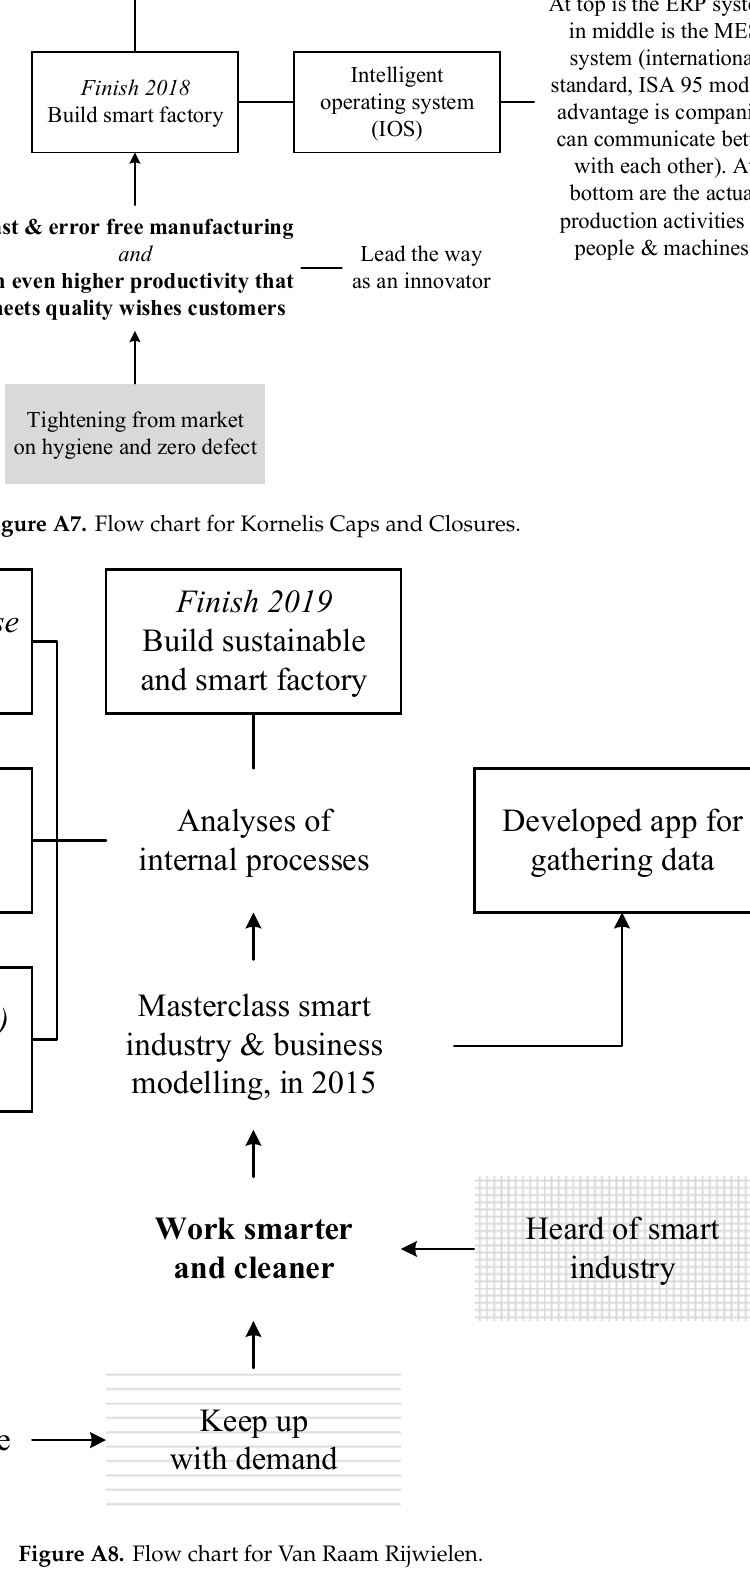
Figure A8. Flow chart for Van Raam Rijwielen.